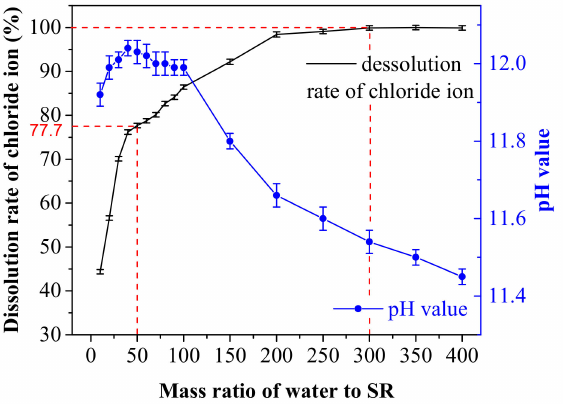
Figure 2. Dissolution rate of chloride ( black ) and pH value ( blue ) with different mass ratio of water to